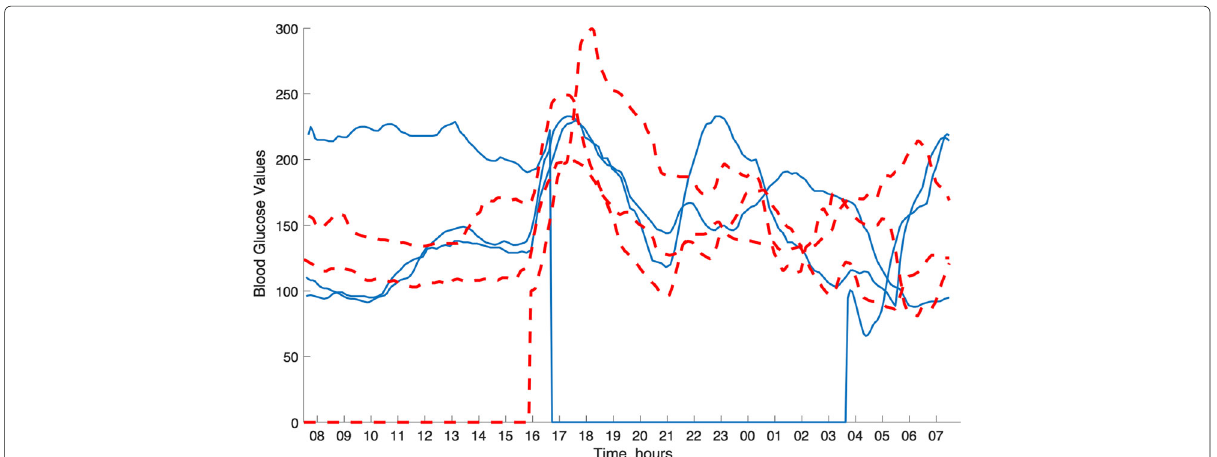
Fig. 1 Examples of blood glucose profile of two patients (solid and dashed lines, respectively). Each curve represents a blood glucose profile for a 24-h period from 08:00 till 07:59 the next day during a 3-day inpatient stay. Notice signal dropouts of several hours for two out of six glucose